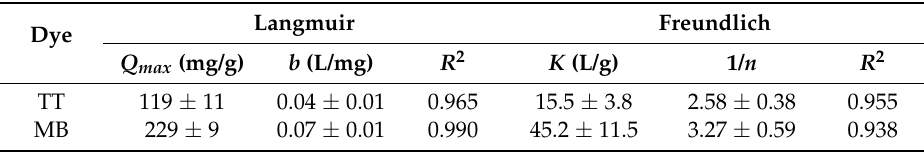
Table 2. Langmuir and Freundlich equilibrium parameters ( ± SD) obtained by non-linear regression analysis for TT and MB biosorption by V. dubyana biomass in single systems. Langmuir Dye